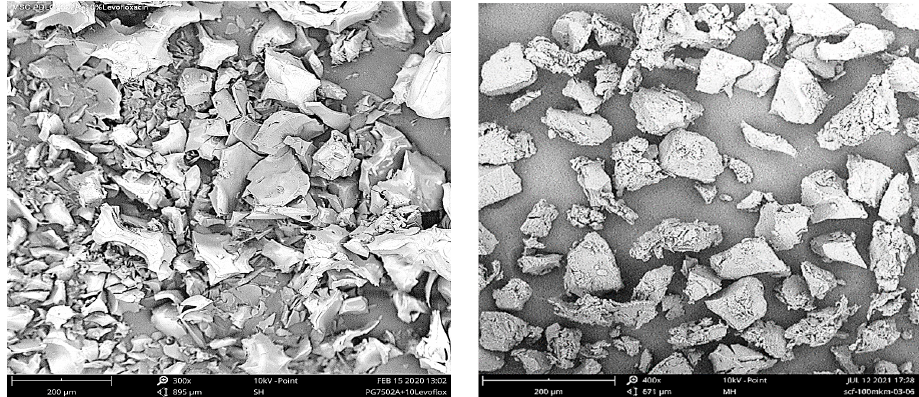
Figure 4. SEM images of polymer microparticles produced by means of cryogrinding from PLGA/LFX scaffolds fabricated using scCO 2 ( left ) and scCHF 3 ( right ). PLGA/LFX scaffolds fabricated using scCO 2 ( left ) and scCHF 3 ( right